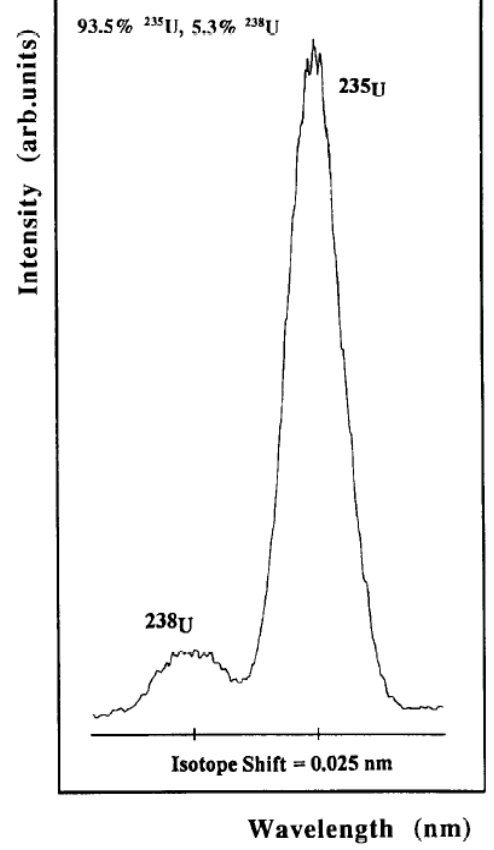
Figure 14. LIBS spectra of 235 U (93.5%) and 238 U (5.3%) Reprinted from reference